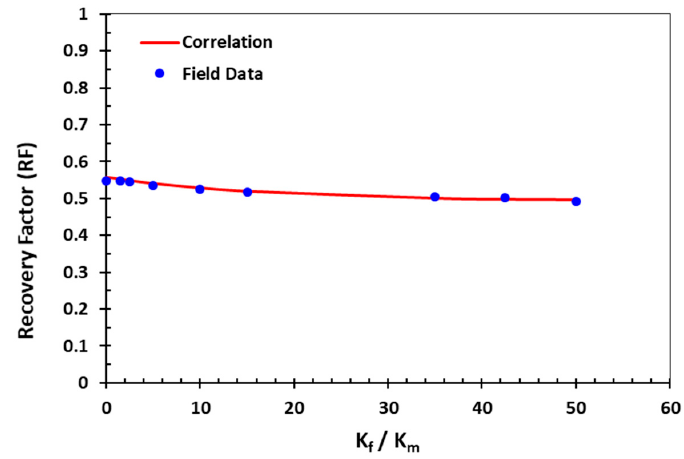
Figure 13. RF vs. fracture permeability to matrix permeability ratio for the database analyzed.